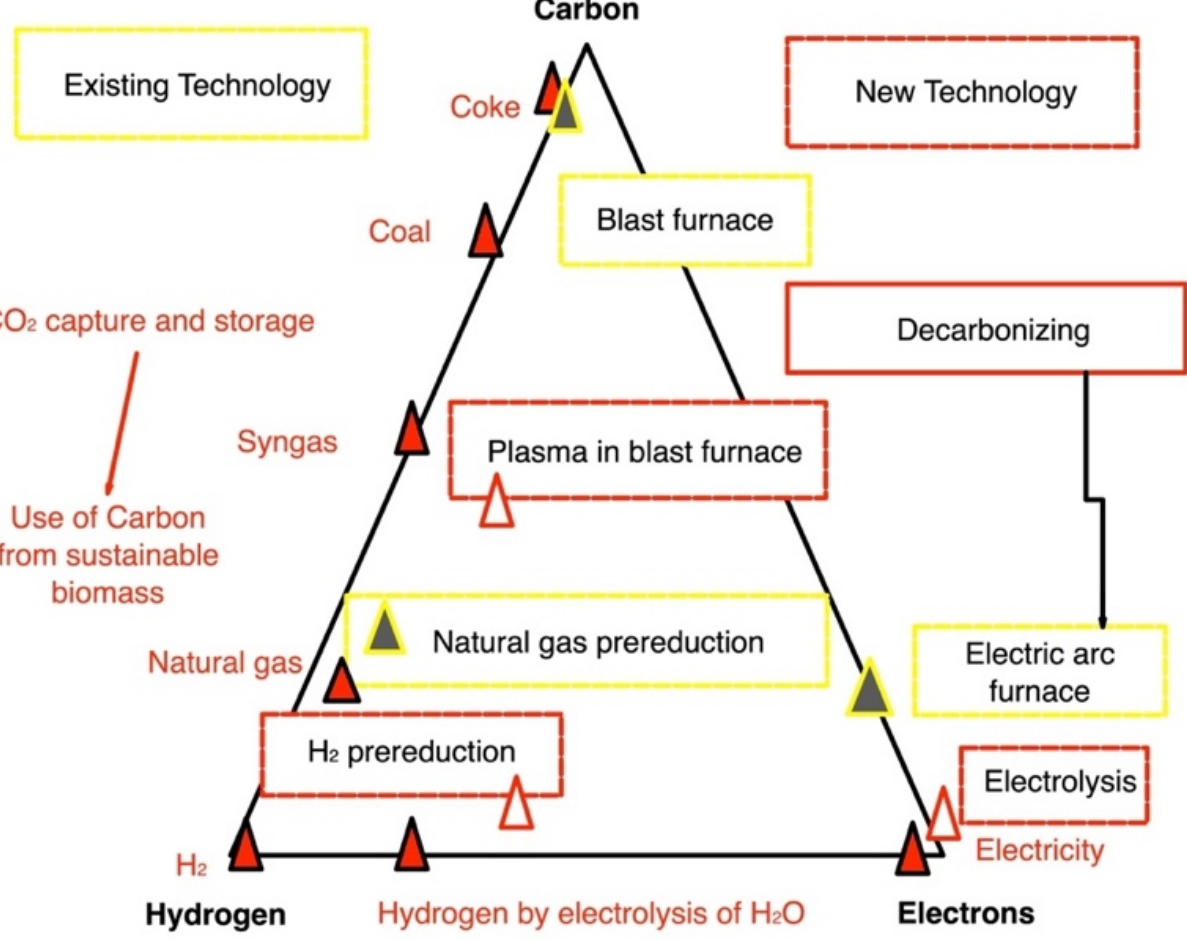
Figure 11. Layout of ULCOS breakthrough technologies for reducing CO 2 emissions [192].